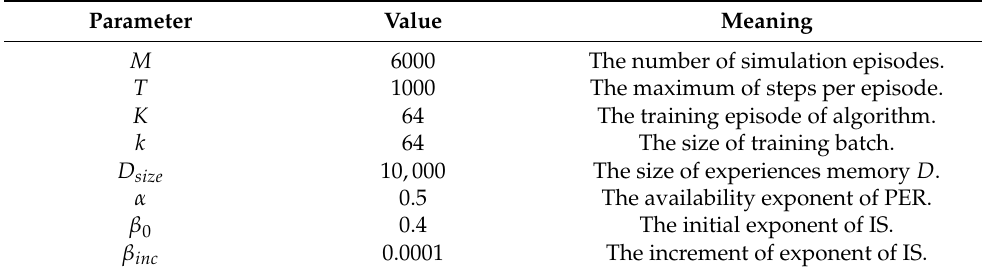
Table 6. The parameters assignment of algorithm.